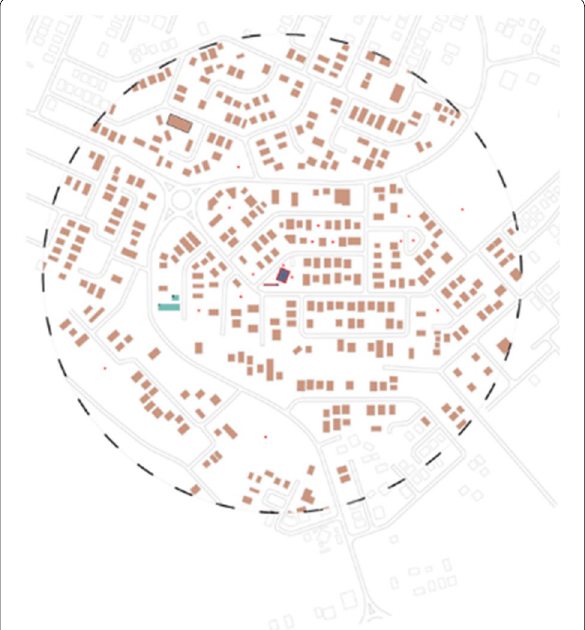
Fig. 2 The following map corresponds to the questions on land-use examined in the IPEN/NEWS survey in the neighborhood of Al Ansab. For an overview of questions to mapping elements, see Additional file 1: Appendix